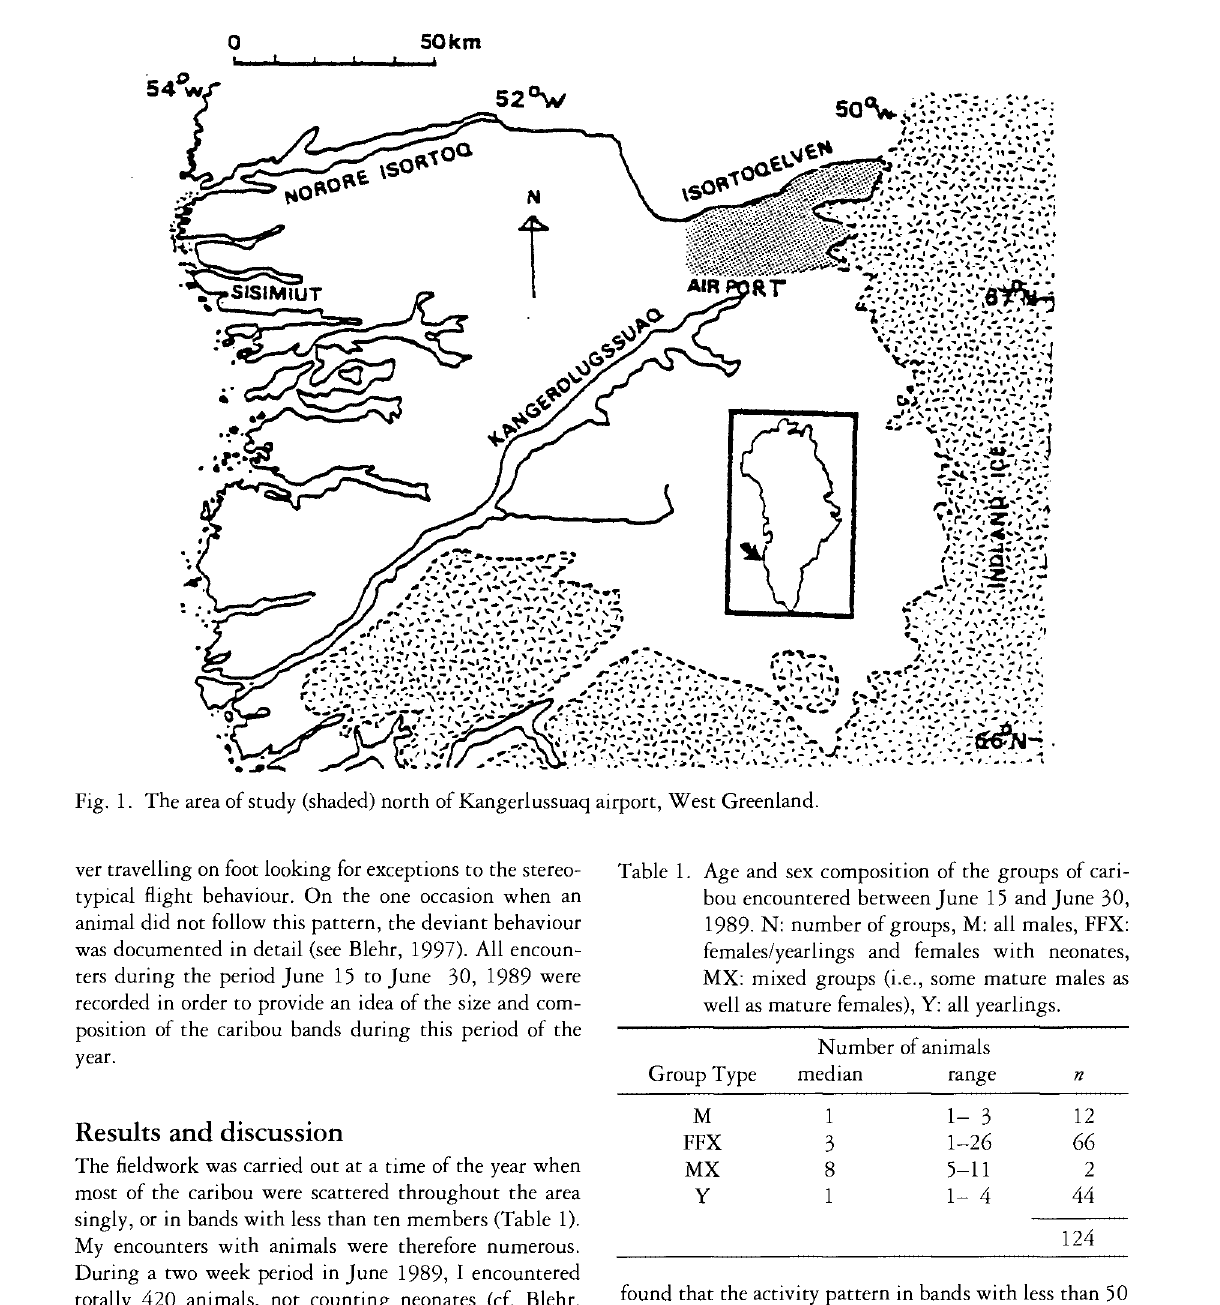
Table 1. Age and sex composition of the groups of cari bou encountered between June 15 and June 30, 1989- N: number of groups, M: all males, FFX: females/yearlings and females with neonates, MX: mixed groups (i.e., some mature males as well as mature females), Y: all